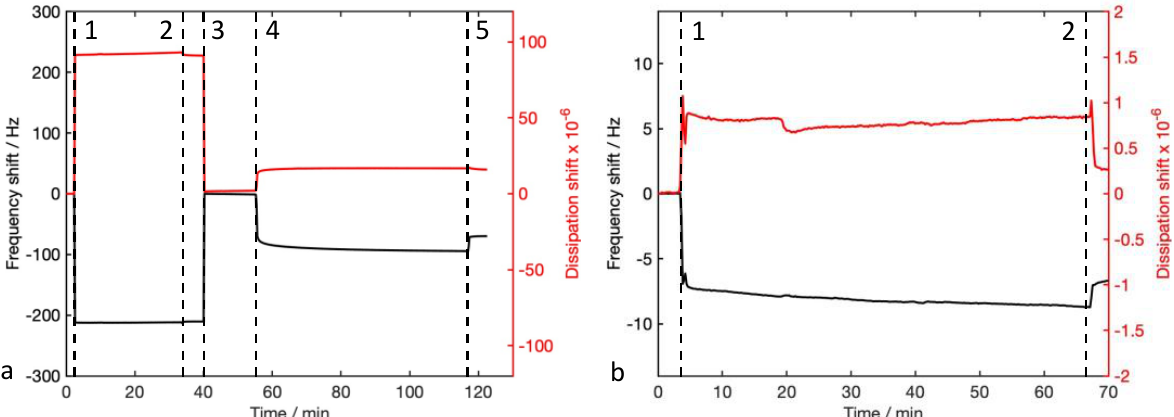
Figure 2. QCM traces of functionalization with ( a ) proteins, ( b ) peptides; in functionalization with proteins, 1: injection of the 12-MCA solution, 2: rinsing with EtOH/water, 3: rinsing with water, 4: injection of the protein solution (in this example, BSA), 5: rinsing with water; in functionalization with peptides, 1: injection of the peptide solution (in this example, MP-5), 2: rinsing with water.